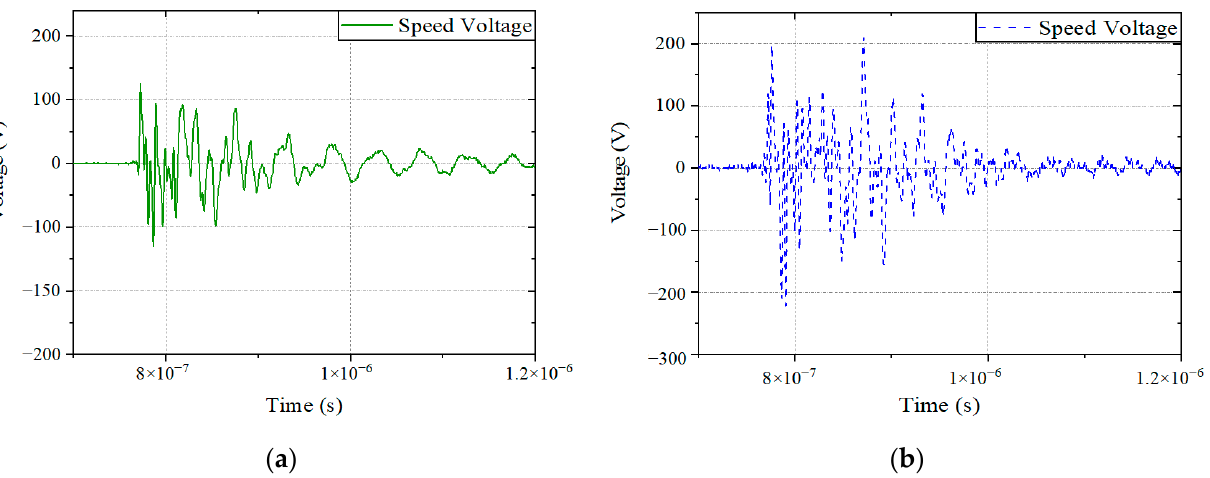
Figure 7. The time domain signal of the speed voltage: ( a ) Electric field strength is 10 kV/m; ( b ) Electric field strength is 20 kV/m.